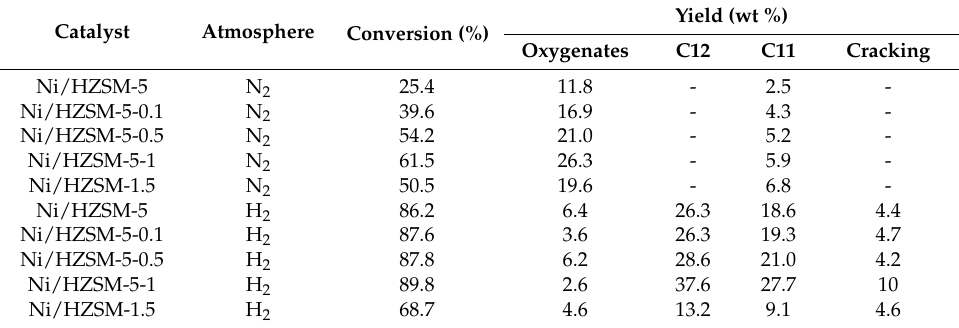
Experimental conditions: methyl laurate (3.5 mmol), n ‐ hexane (20 mL), catalyst (0.1 g), 280 °C, 2 MPa of N 2 or H 2 (room temperature), and stirring at 600 rpm for 5 h.